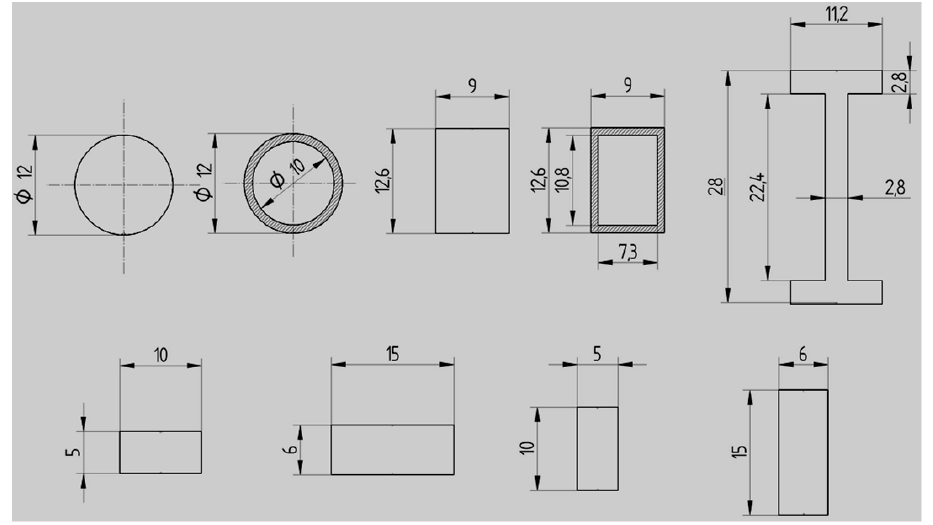
Figure 3. Dimensions and shapes of the specimens (ISO metric drawing standard).